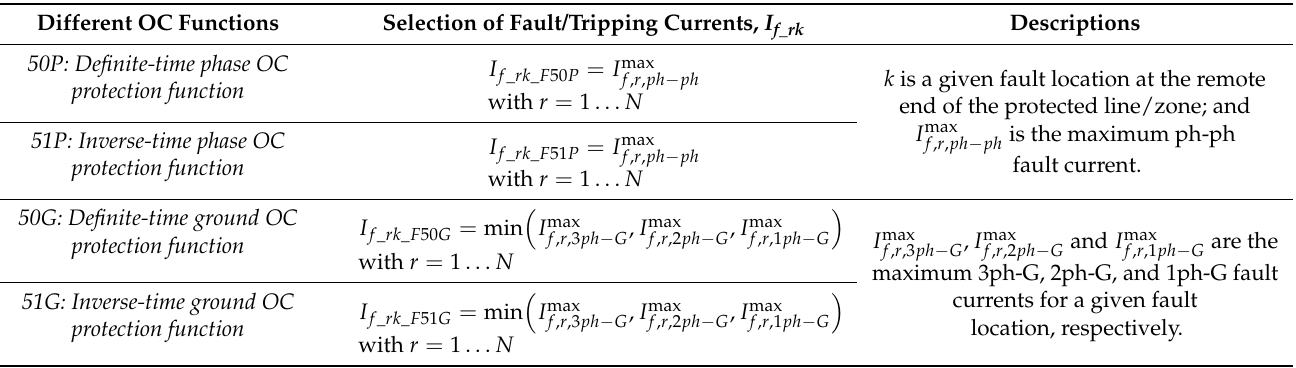
Table 1. Fault-current selection for the 50 and 51 OC